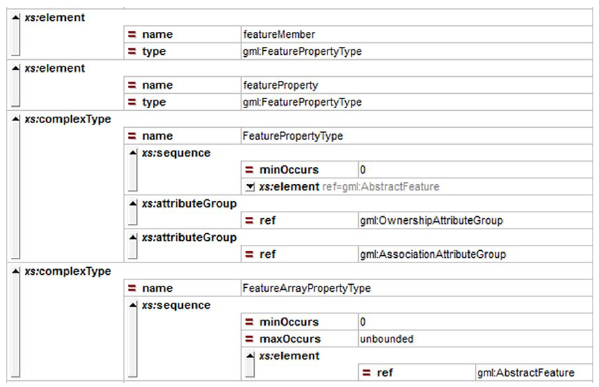
Fig. 11. The featureMember schema diagram in